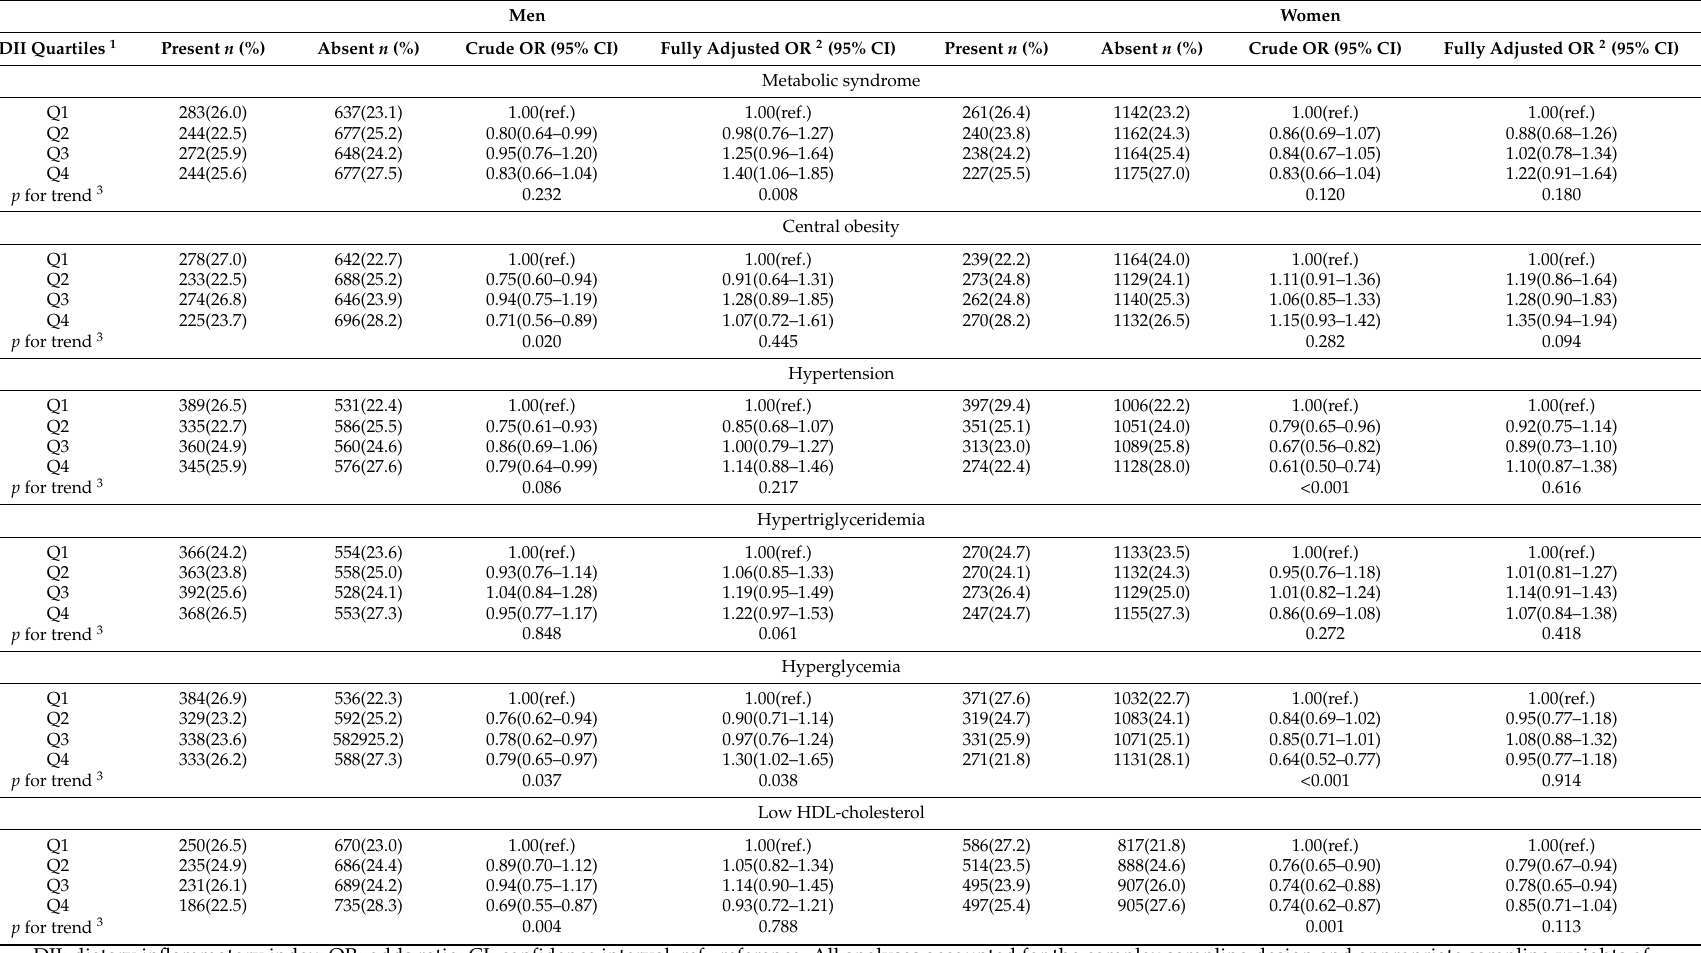
Table 3. Odds ratio of metabolic syndrome and its components by DII